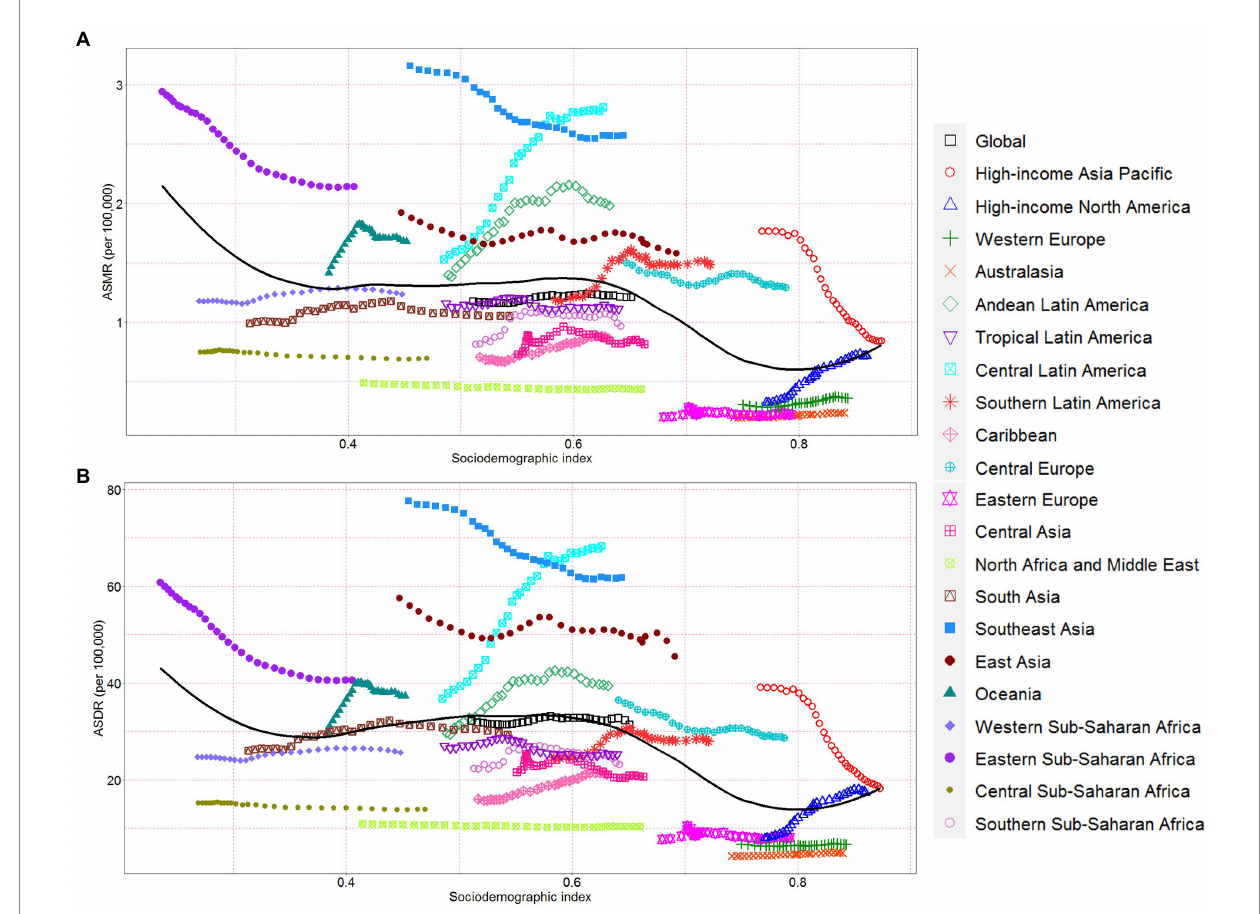
FIGURE 4 Chronic kidney disease-related ASMR and ASDR attributable to high sodium intake across 21 Global Burden of Disease regions by socio-demographic index for both sexes combined, 1990–2019. For each region, points right depict estimates from each year from 1990 to 2019. (A) The correlation between chronic kidney disease-related ASMR attributable to high sodium intake and socio-demographic index. (B) The correlation between chronic kidney disease-related ASDR attributable to high sodium intake and socio-demographic index. ASMR, age-standardized mortality rate; DALY, disability- adjusted life year; ASDR, age-standardized DALY